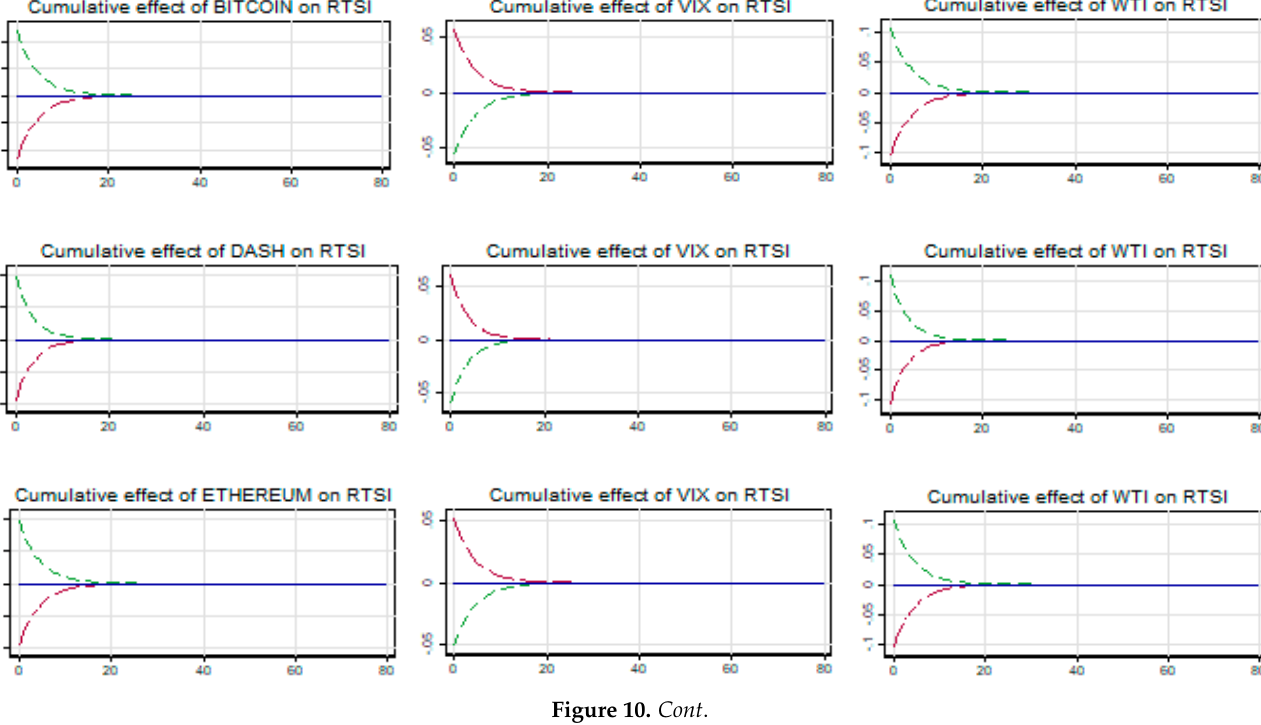
Figure 10. Cumulative effects of cryptos and gold on RTSI. 4.3. Comparative Analysis of Pre- and during the COVID-19 Financial Crisis Period The following Table 15 presents the summary of the pre- and during COVID-19 anal- ysis of the safe haven opportunity of five cryptocurrencies and gold for five BRICS mar- kets. Table 15. Summary of the safe haven analysis.